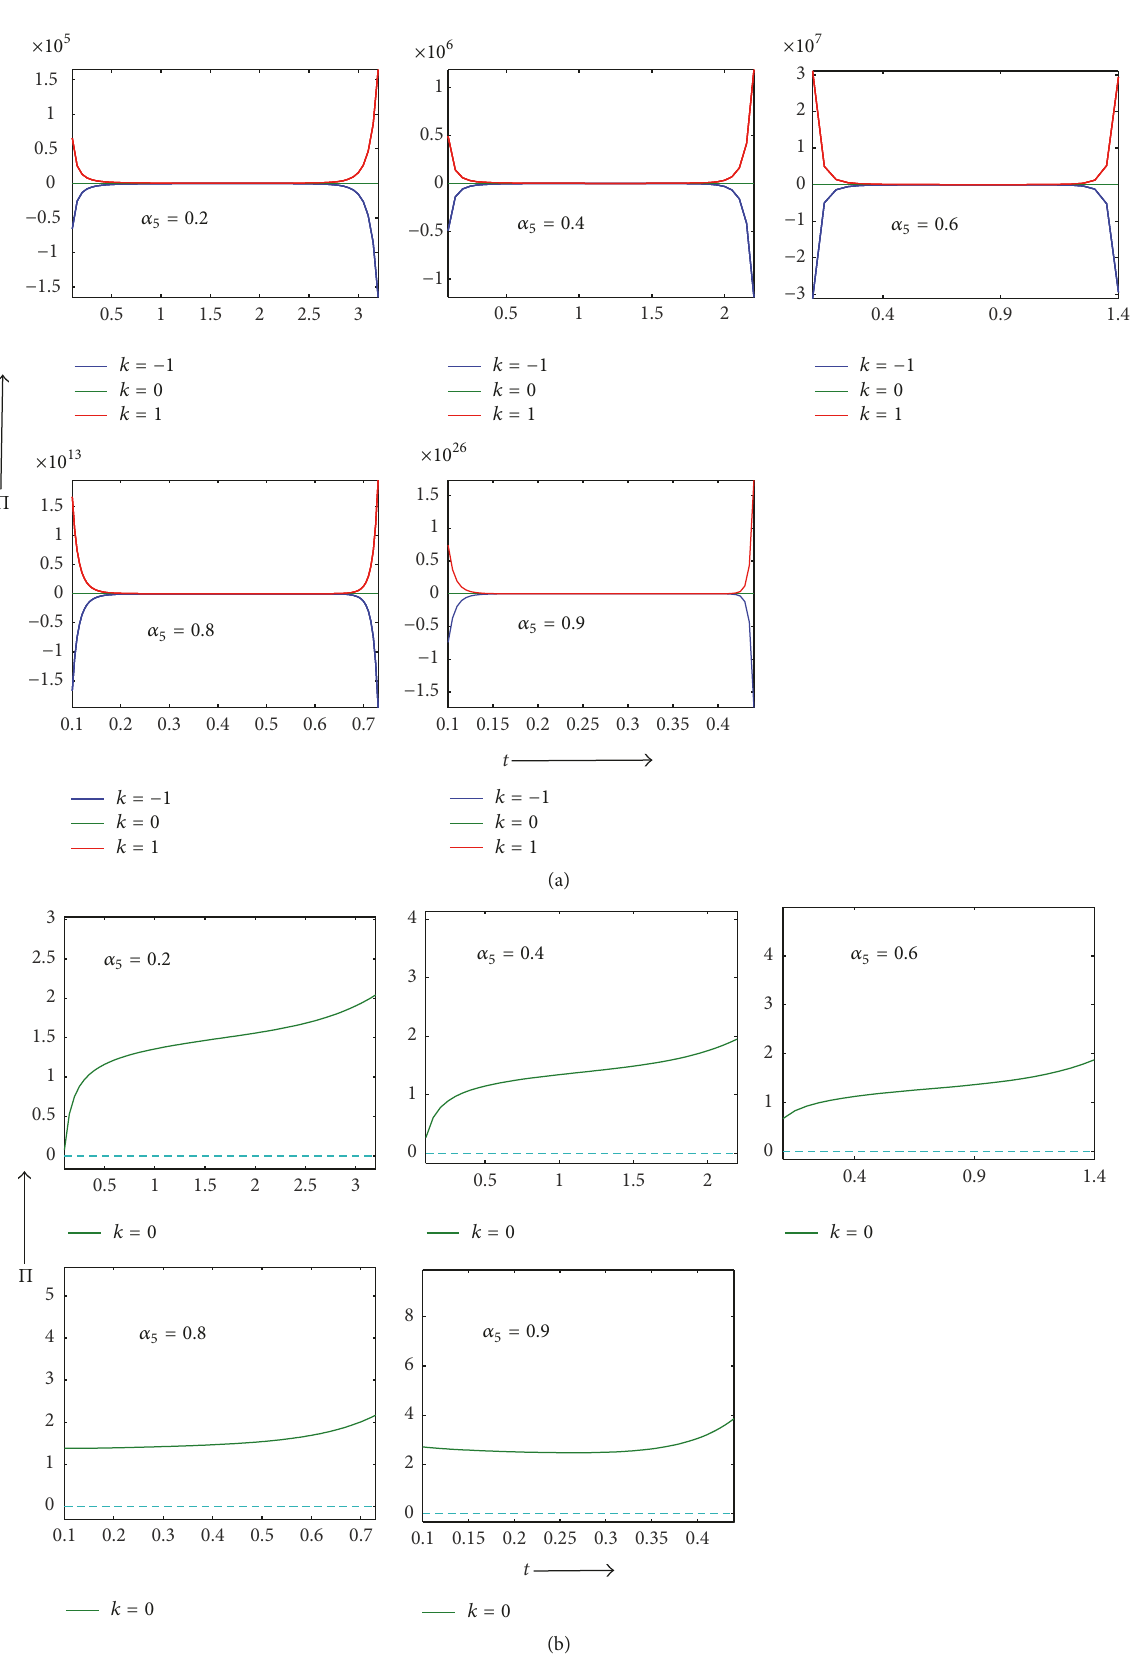
Figure 23: Variation of bulk viscous stress Π against time for 𝛼 1 = 0.5 , 𝐴 = 1 , 𝐵 = 1 , 𝑛 = 0.1 , 𝜔 = 1 , 𝜙 0 = 1 , 𝑐 2 = 0.1 , and different 𝛼 5 . (b) shows the zooming of